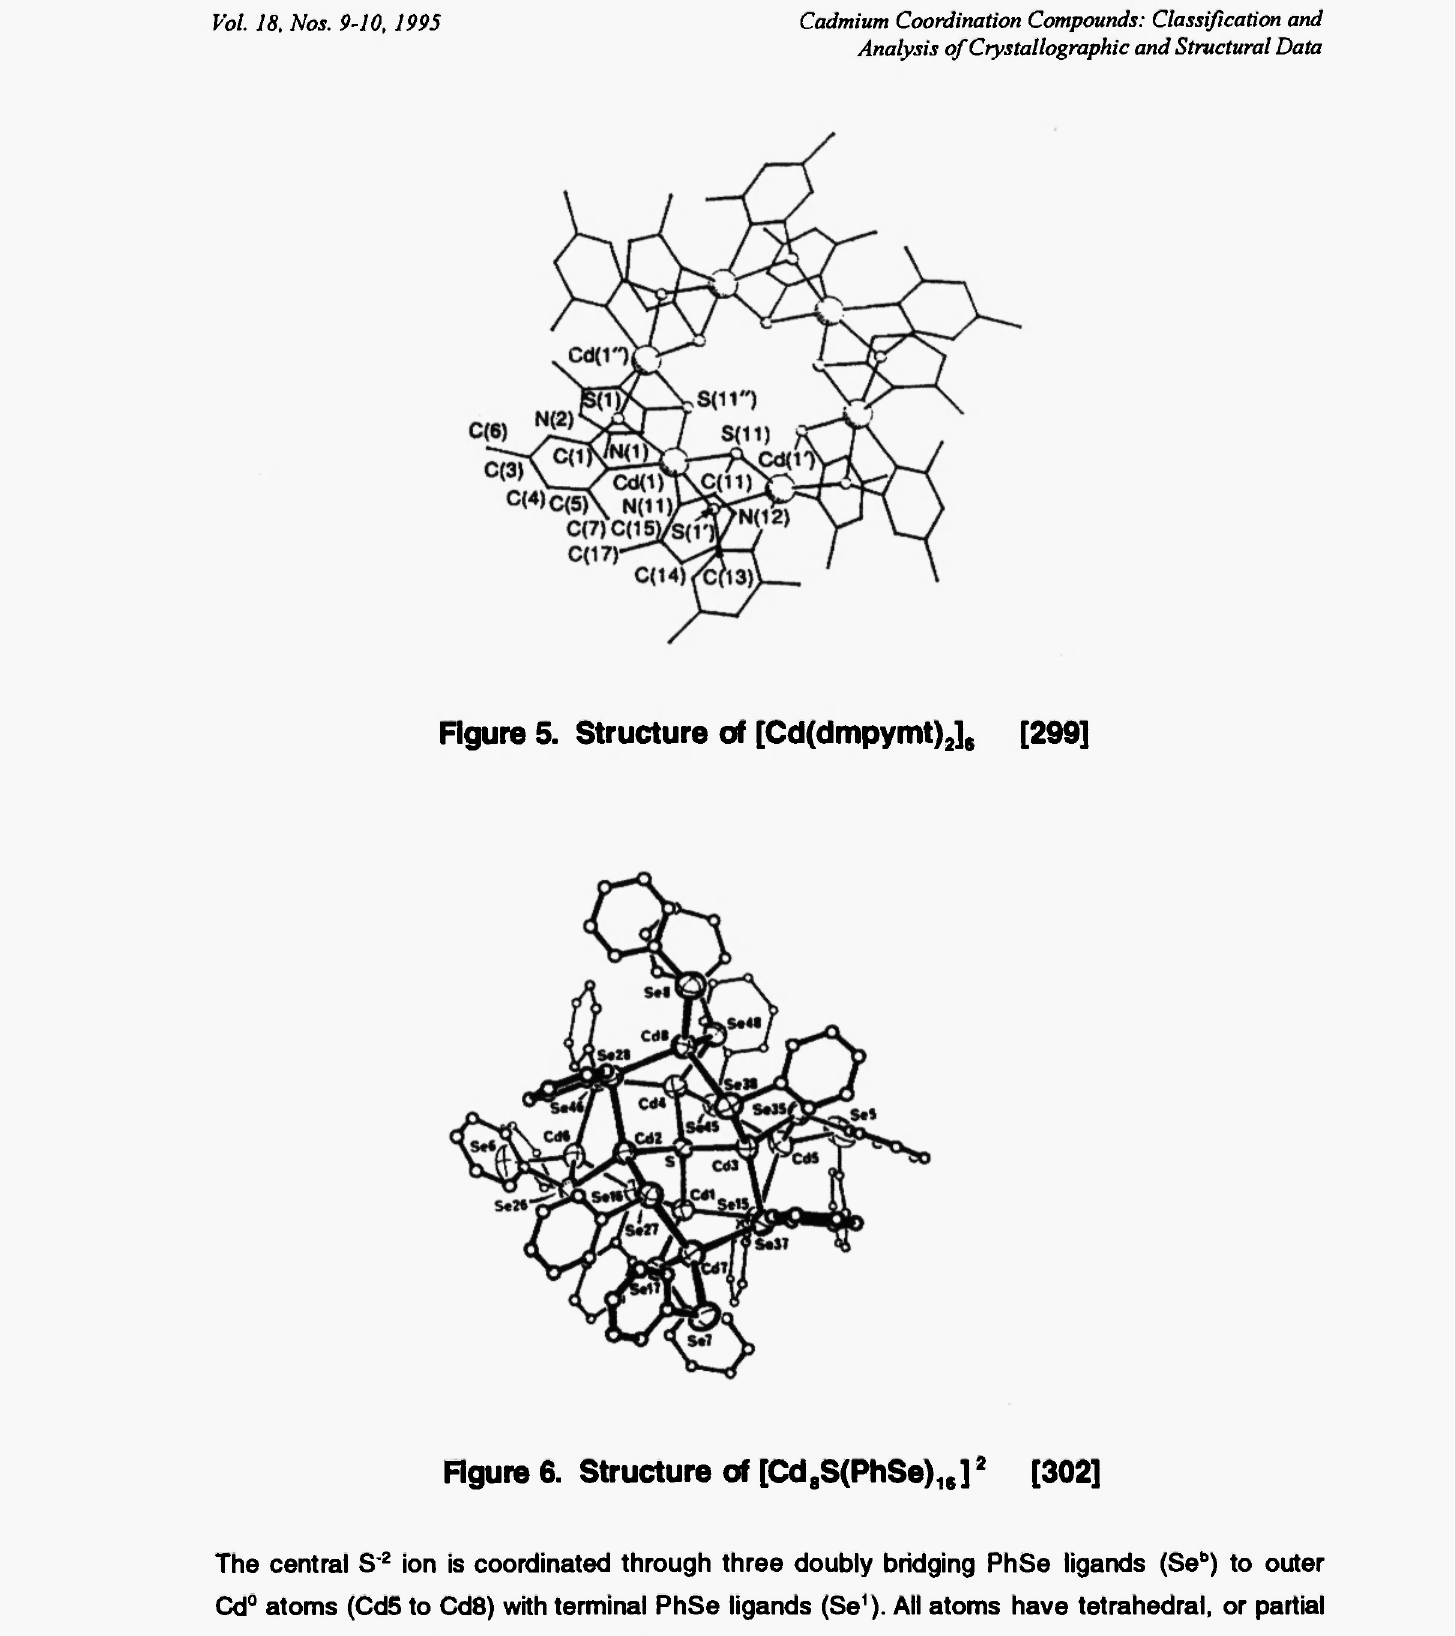
Figure 6. Structure of [Cd